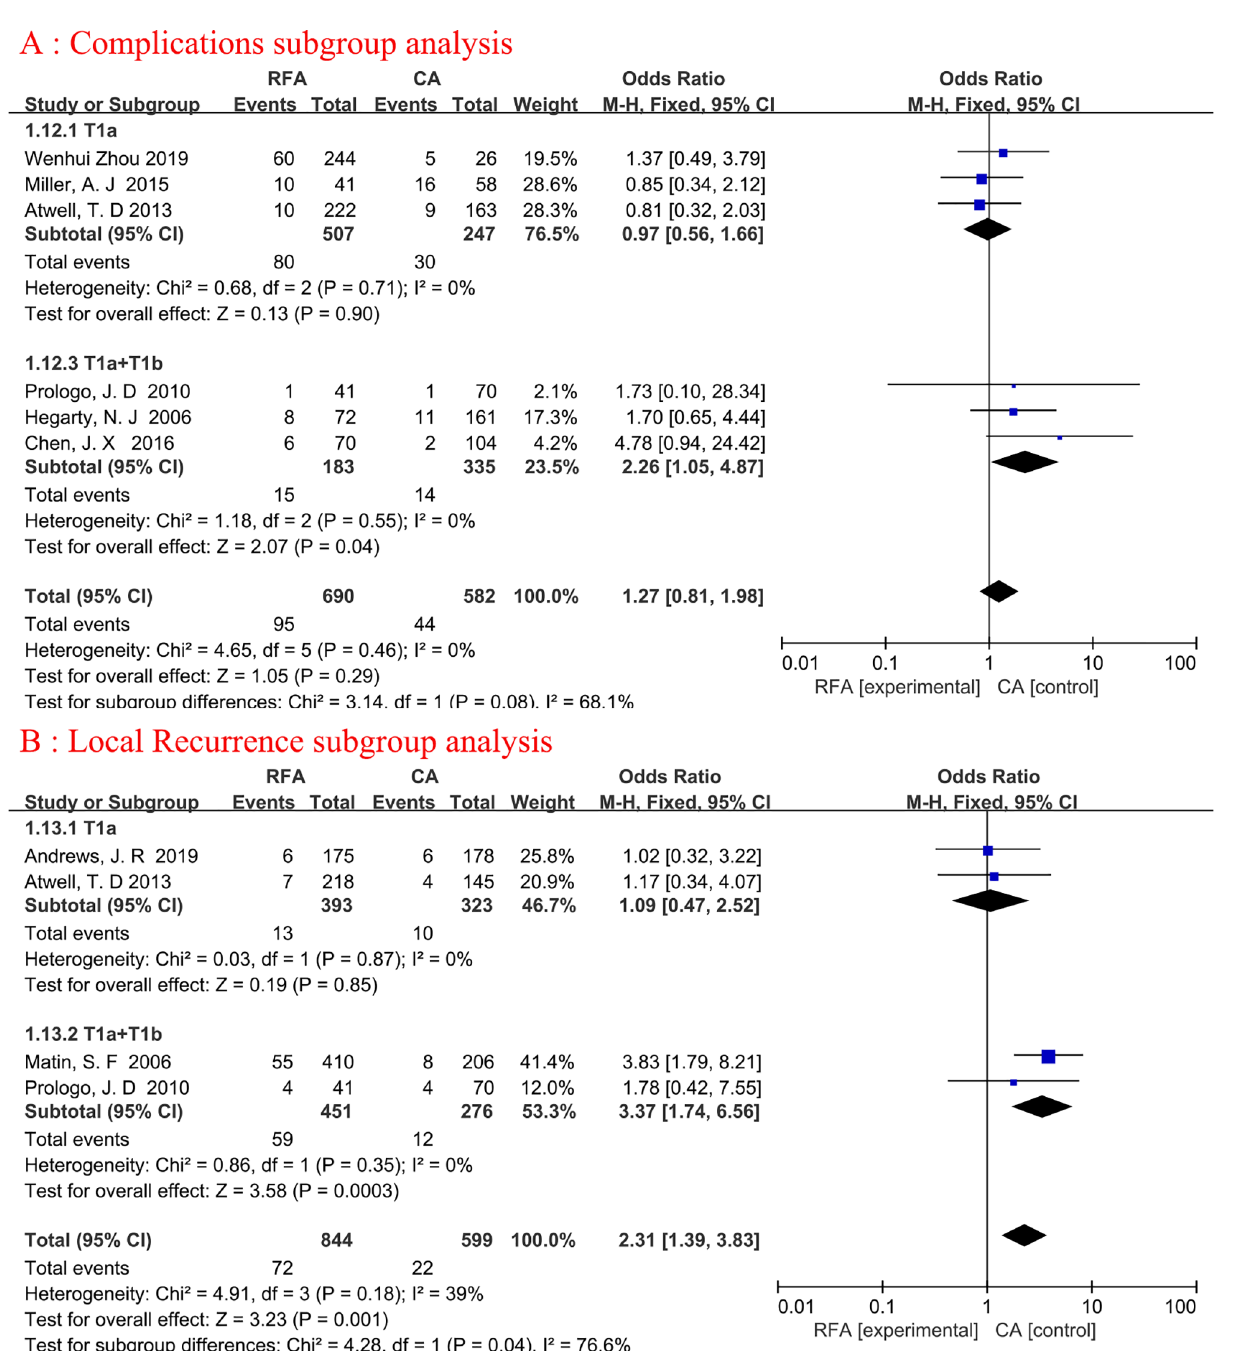
FIGURE 5 | Forest plot and meta-analysis of complications subgroup analysis (A) and local recurrence subgroup analysis (B)